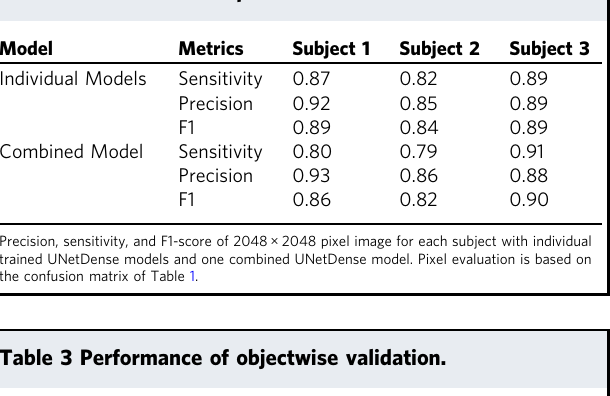
Table 2 Performance of pixelwise validation.